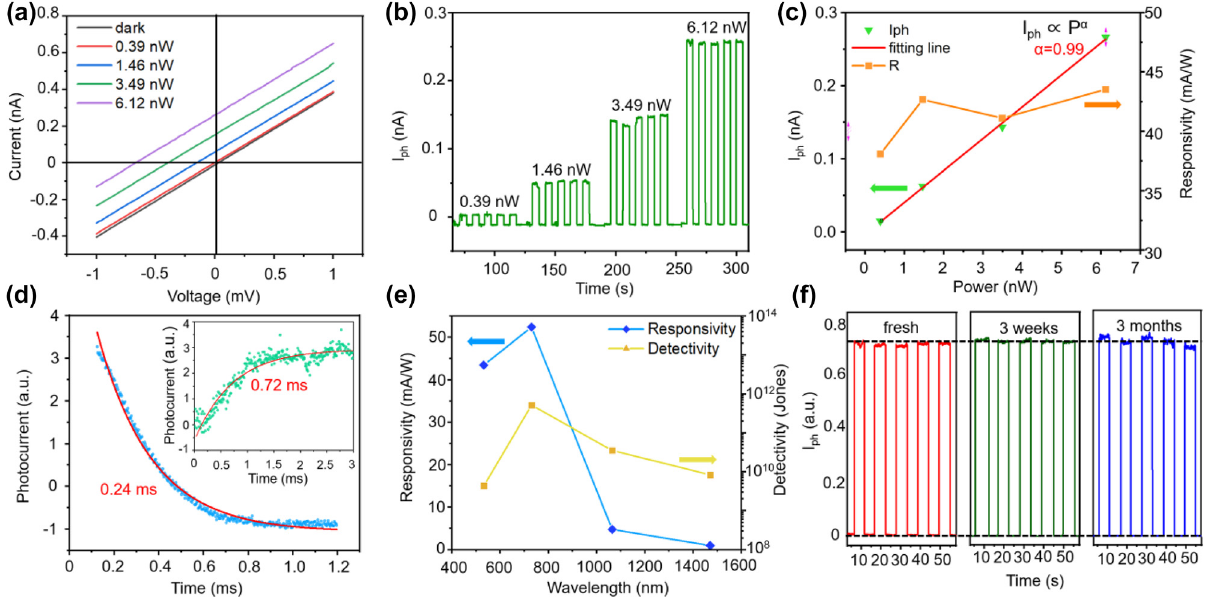
Figure 3: The performance of the PdSe photodetector. (a) The I – V curves of the photodetector under dark and global illumination with a 532 nm 2 laser. The power changes from 0.39 nW to 6.12 nW. (b) Time dependence of photoresponse under pulsed laser radiation with various powers ranging from 0.39 nW to 6.12 nW at zero bias. (c) The power dependence of photocurrent and responsivity under a wavelength of 532 nm. The fitting line is the red solid line plotted by the power law, demonstrating a linear relationship between photocurrent and incident light power. (d) The illustration of the rise time (0.72 ms) and decay (0.24 ms) time of the photoresponse, indicates a fast response speed. All data were measured under a 532 nm laser with photodetector as a function of the incident laser wavelength. (f) The a fixed power. (e) The spectral responsivity and detectivity of the PdSe 2 photocurrent as a function of the time measured with a pulsed 532 nm laser. And the same test was repeated after 3 weeks and 3 months respectively, indicating the long-term stability of this